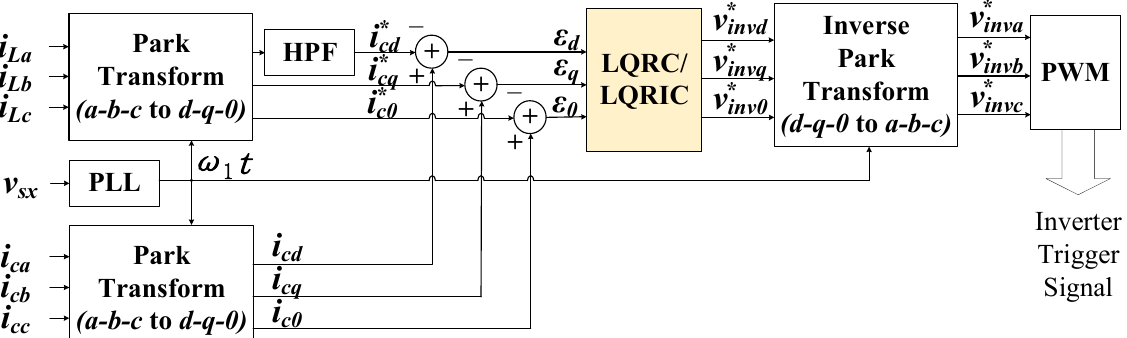
Figure 3. The overall block diagram of LQRC and LQRIC for LC -HAPF.